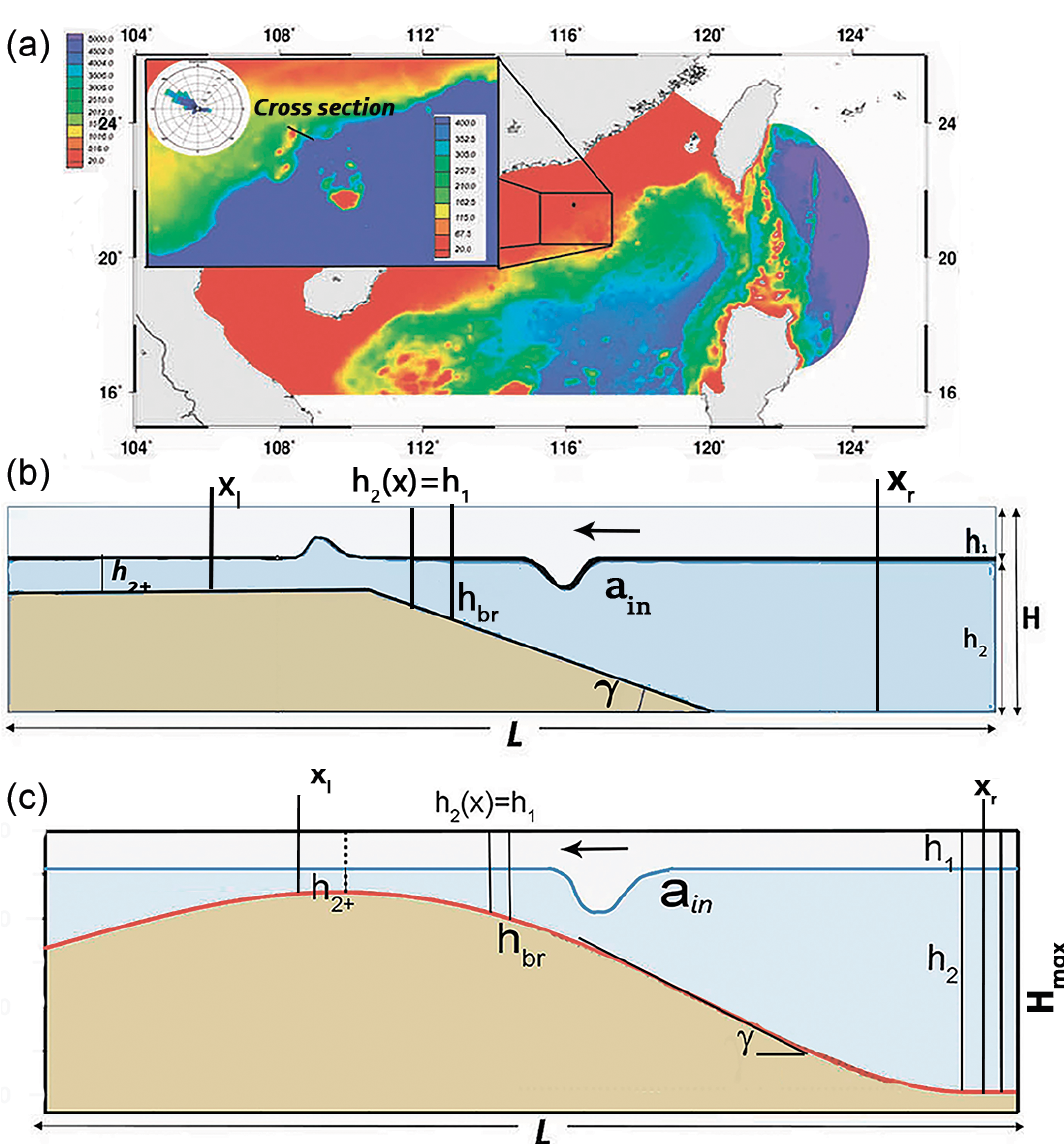
Figure 1. Sketch of the transformation of a depression ISW over a shelf slope. Panel (a) shows the Lufeng region in the South China Sea, panel (b) is a sketch of wave breaking and the changing of the polarity of an ISW of depression after passing through a turning point, and panel (c) displays the idealized topography in the Lufeng